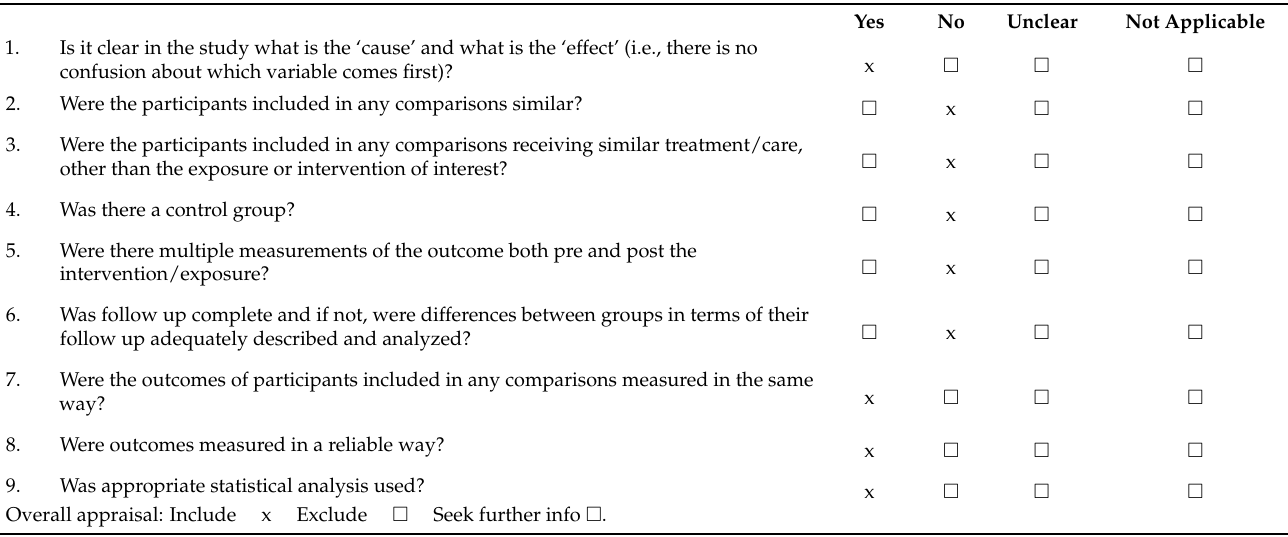
Table A3. JBI Critical Appraisal Checklist for quasi-experimental studies—Artal et al. (1995) study. Citation: Artal, R.; Fortunato, V.; Welton, A.; Constantino, N.; Khodiguian, N.; Villalobos, L.; Wiswell, R. A Comparison of Cardiopulmonary Adaptations to Exercise in Pregnancy at Sea Level and Altitude. Am. J. Obstet. Gynecol. 1995 , 172 , 1170–1178; discussion